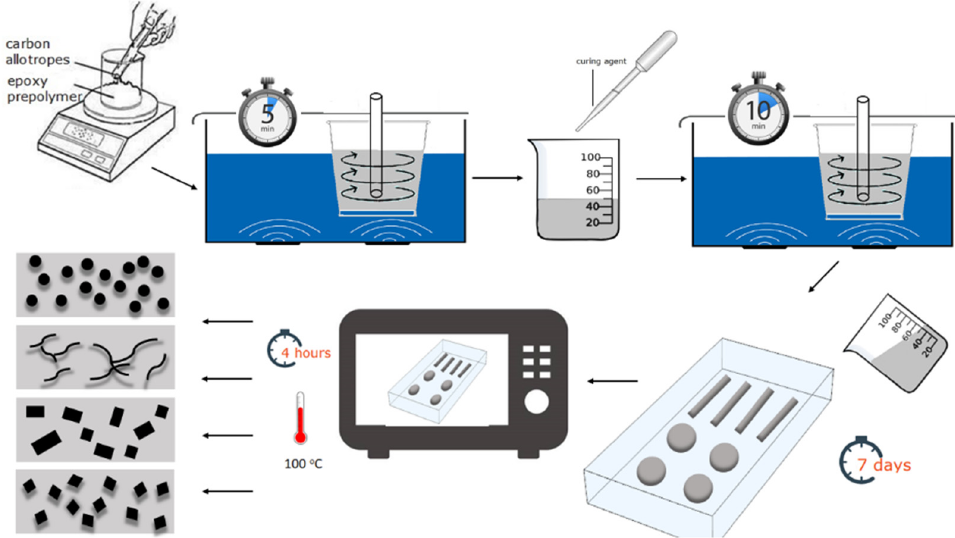
Figure 1. Schematic representation of the fabrication process of the nanocomposites.